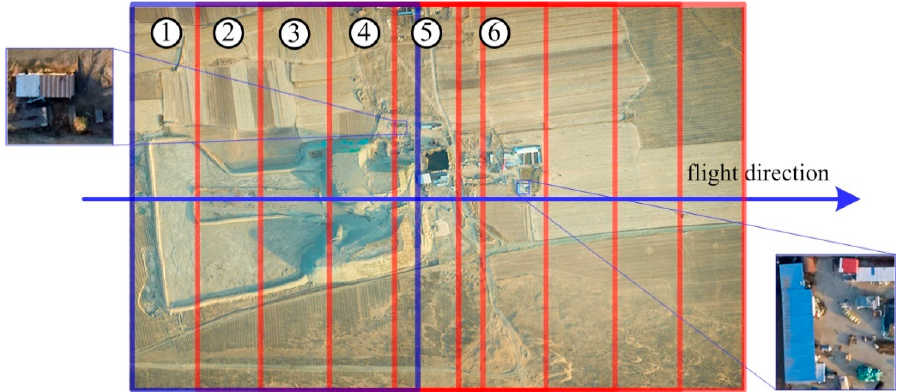
Figure 14. Mosaic image series of six successive images.